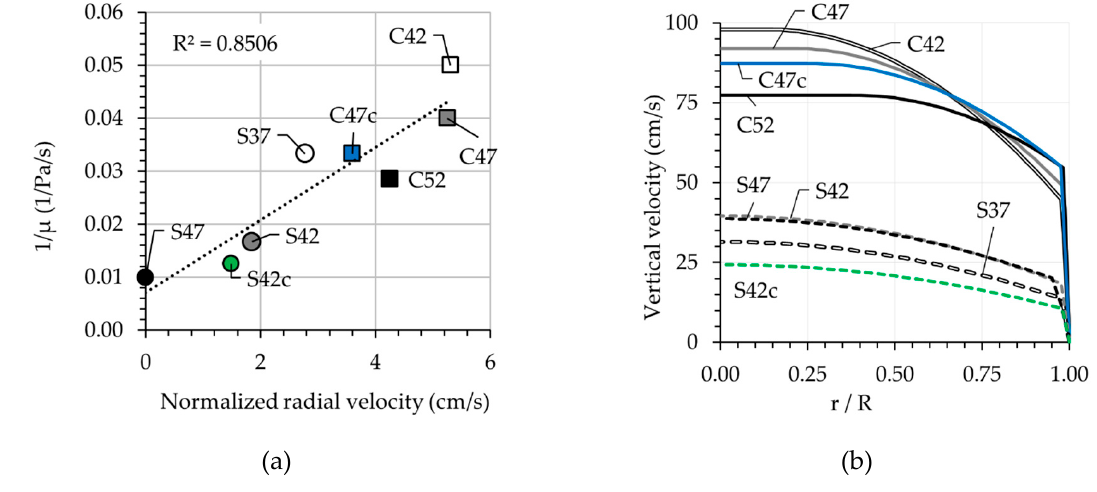
Figure 12. ( a ) Relation between normalized radial velocity at ∆ P max = 22.996 kPa / m according to the pressure sensor from Sliper and the inverse of bulk viscosity and ( b ) velocity profiles determined analytically.